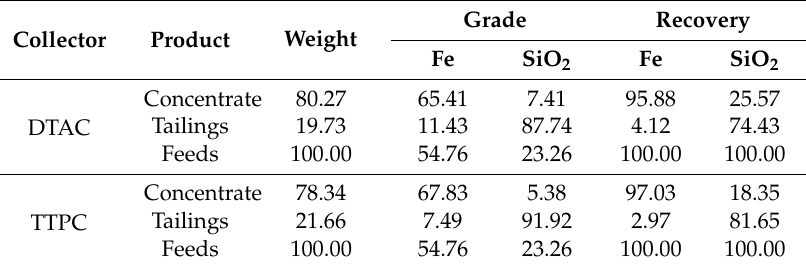
Table 4. The separation results of mixtures (wt